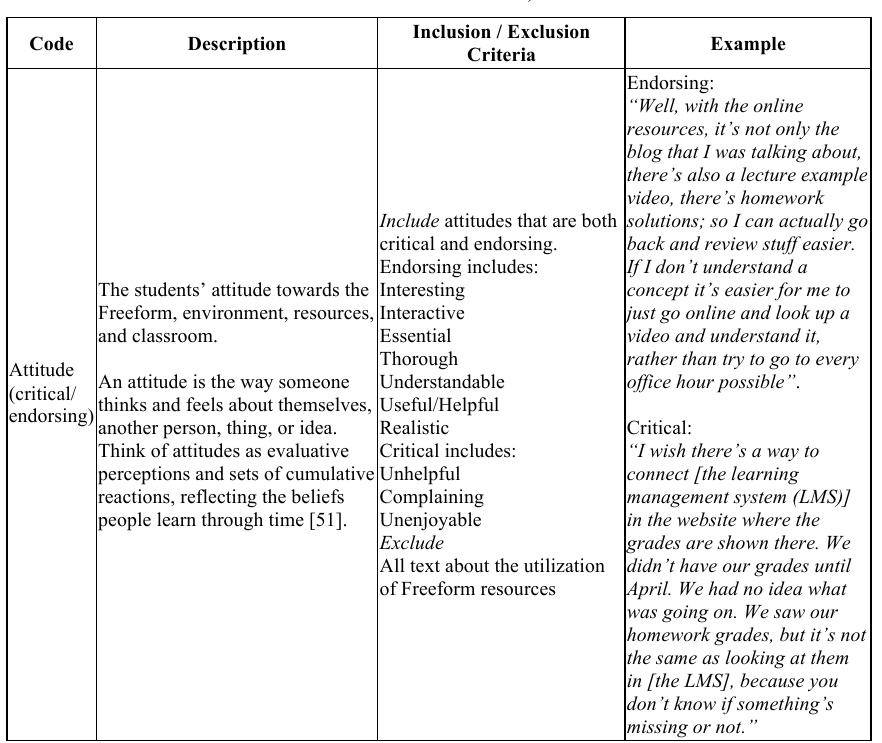
Table 2. Structure of the codebook developed to organize data (one of twenty-six